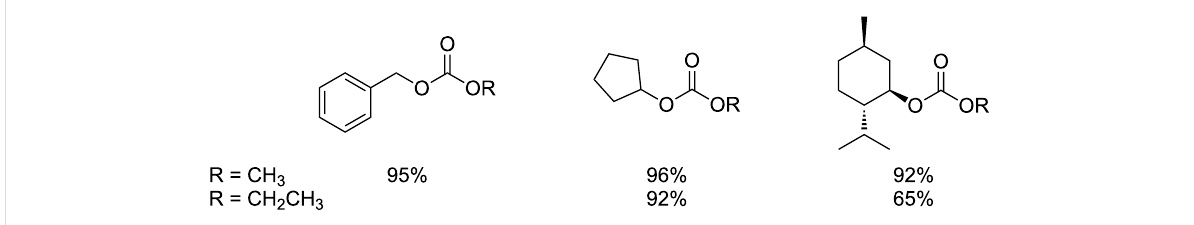
Figure 5: Examples of carbonates obtained through transesterification using phosphonium salts as catalysts.